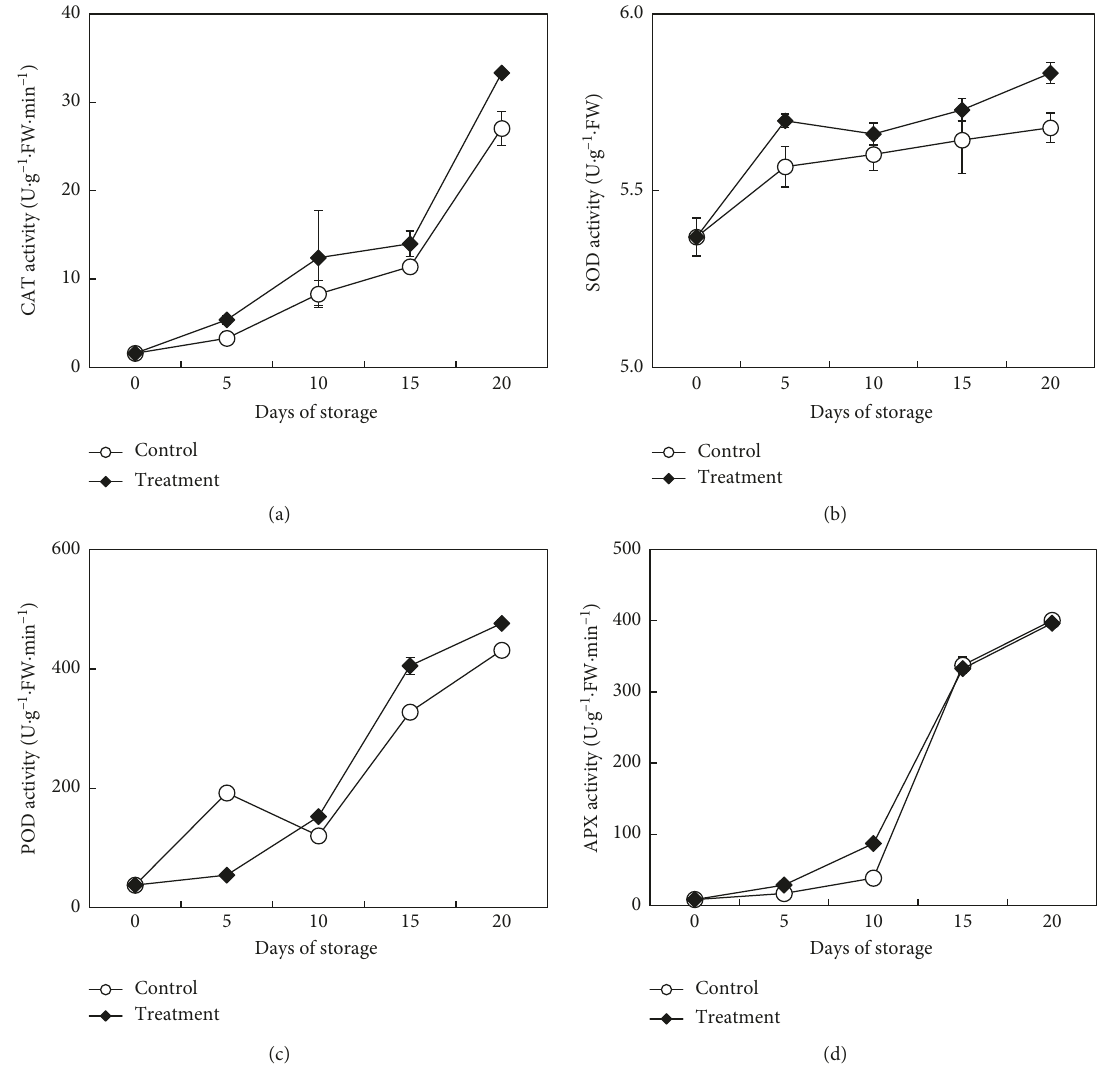
Figure 8: Effects of forced air precooling treatment on CAT (a), SOD (b), POD (c), and APX (d)